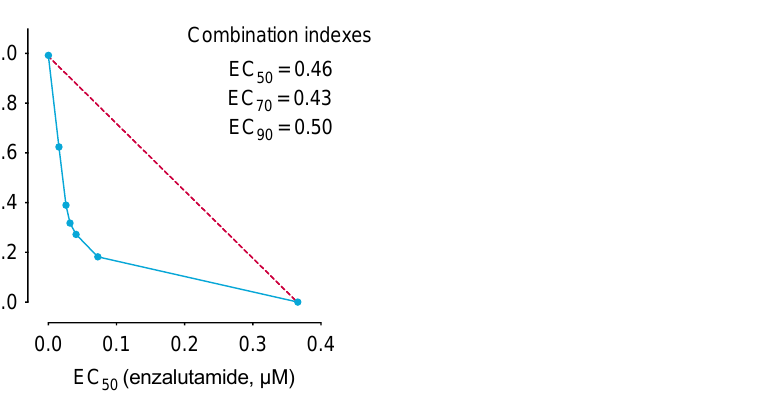
Figure 1. The combination of radium-223 and enzalutamide has synergistic antiproliferative efficacy in vitro . Isobologram for the in vitro combination effect of radium-223 and enzalutamide on the cell viability of LNCaP prostate cancer cells. Combination indexes were calculated for the combination treatment of radium-223 and enzalutamide with 0.3–0.7 defined as synergism and 0.70–0.85 defined as moderate synergism.